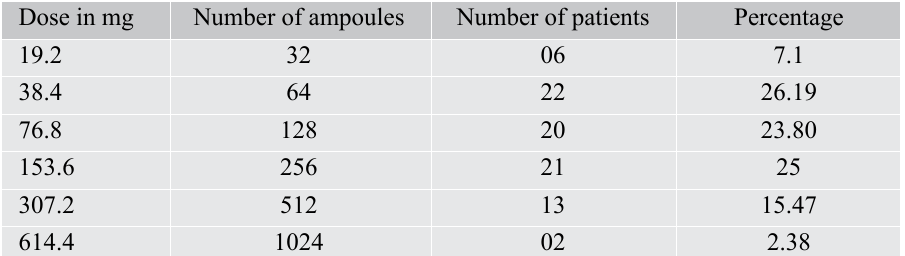
Table V: Loading doses of atropine in acute poisoning cases